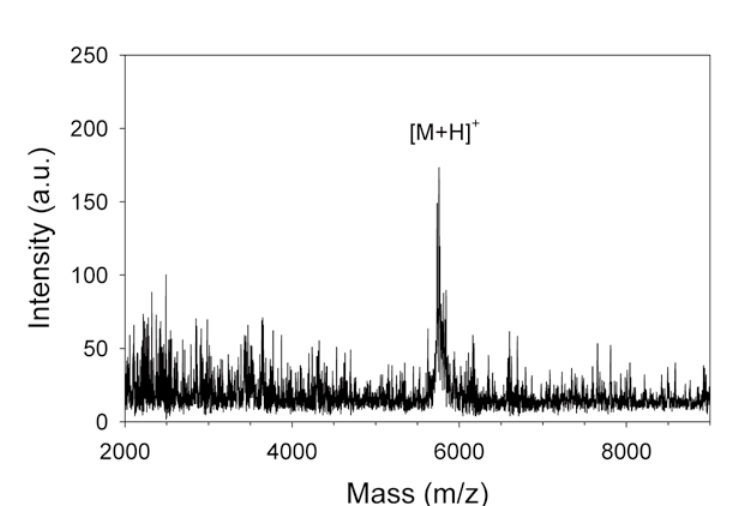
Fig.4 Average MALDI mass spectrum of 0.26-µm aerosol particles of the protein insulin premixed with the matrix 2,5- dihydroxy benzoic acid in a matrix-to-analyte ratio of